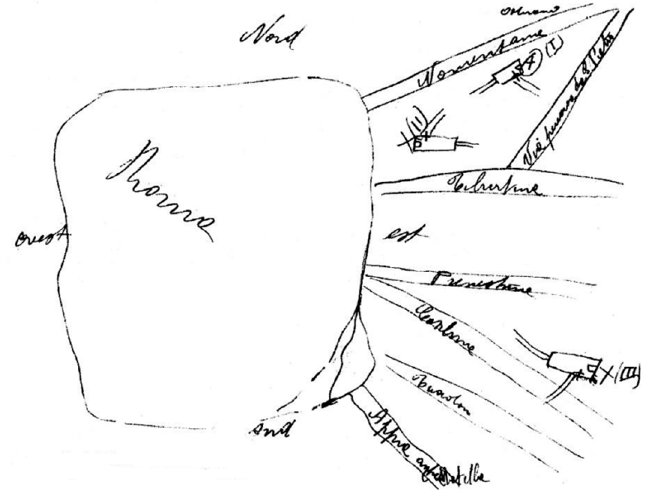
Figure 4. Sketch of the map drawn by Maria Valtorta on 26 August 1948 about three different Peter’s burial sites, referred to the Roman walls [11], p. 14. On the map, she indicates the four Cardinal points and, from North to South: Ostriano, Nomentana, path traveled by Peter, Tiburtina, Prenestina, Casilina, Tuscolana, Appia Antica-Metella.